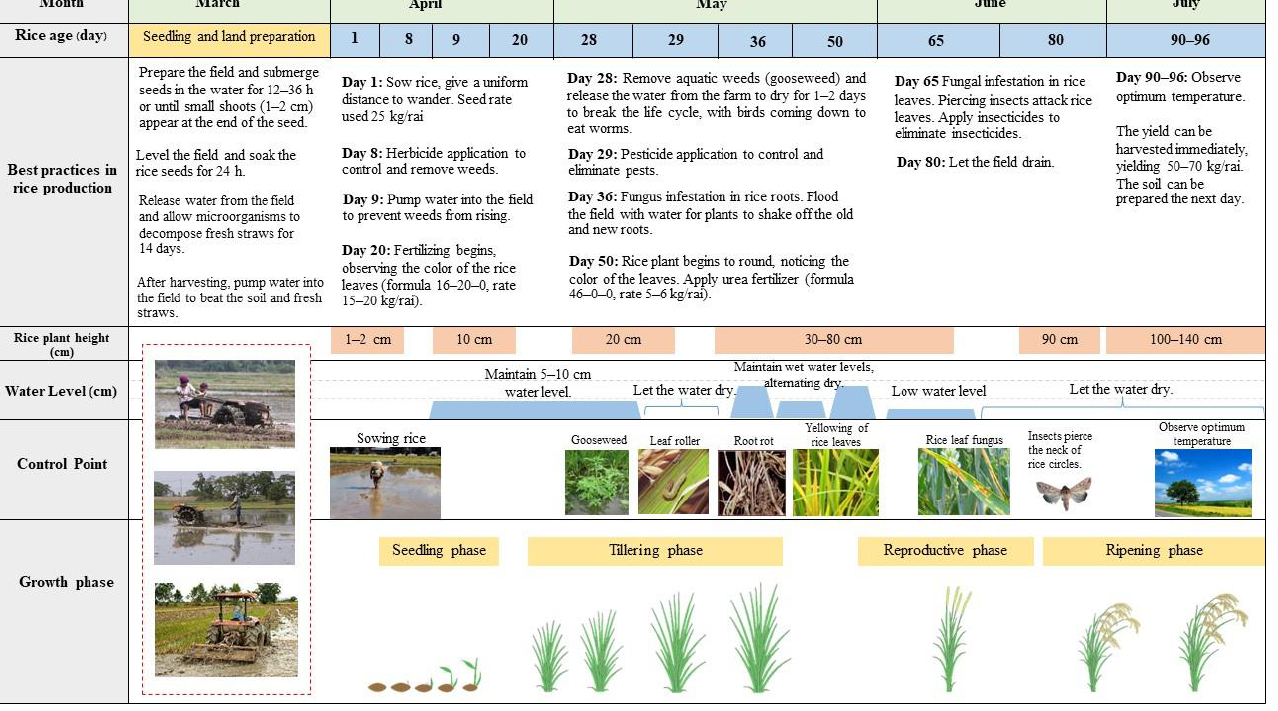
Figure 1. GAP study site’s cropping calendar with alternate wetting and drying (AWD) for GAP- certified rice production.